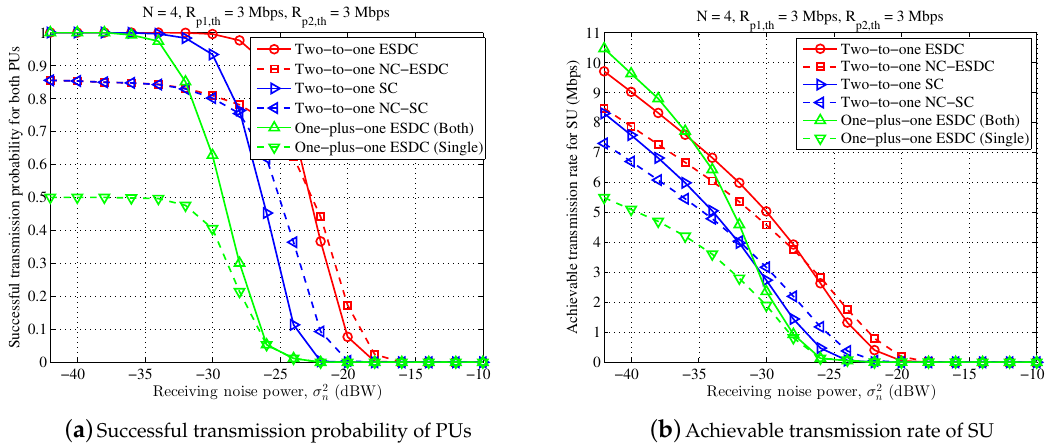
Figure 4. Performance comparison for different receiving noise power, in whic n = 4, R p1,th = 3 Mbps, R p2,th = 3 Mbps.